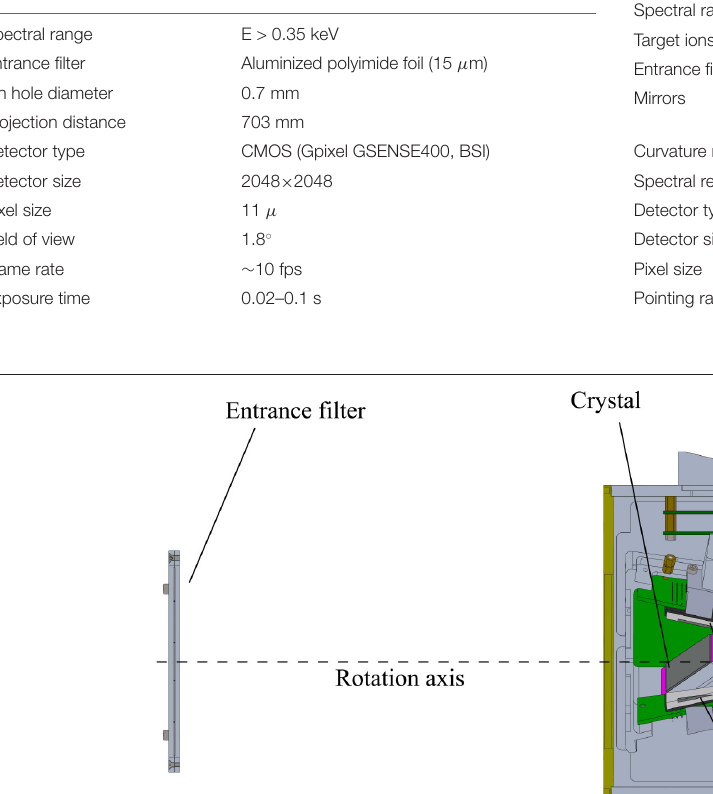
TABLE 6 | Main characteristics of pin-hole X-ray imager (PHI).